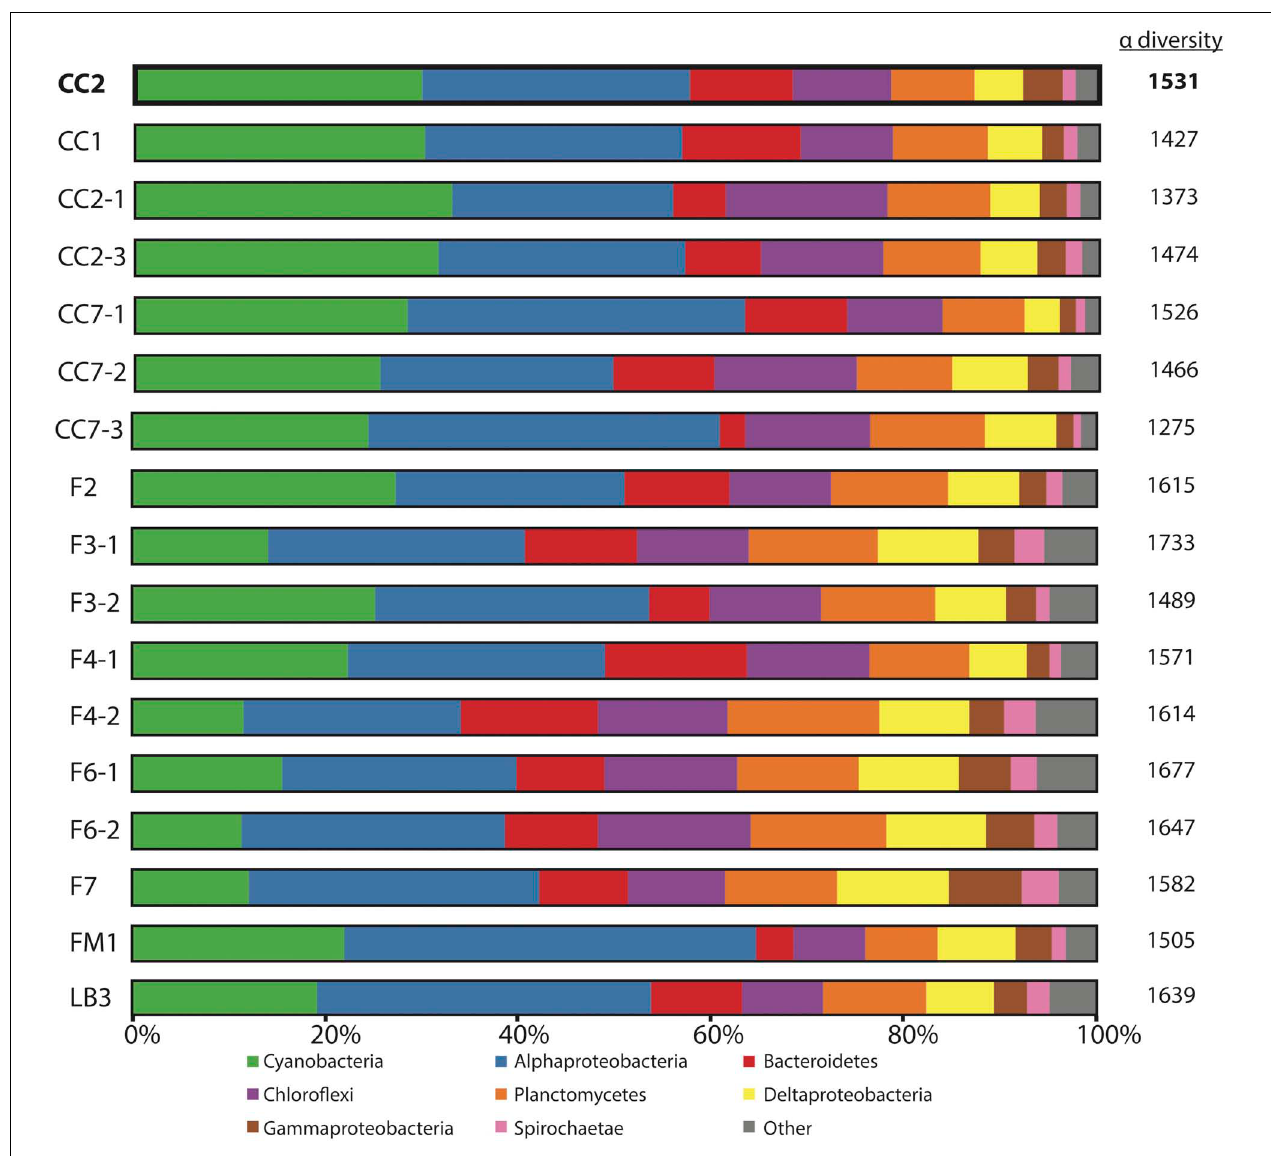
FIGURE 3 | Microbial diversity of polygonal mats recovered using iTag sequencing of the 16S rRNA gene. Relative abundances (%) do not include reads unassigned to any taxon, which comprise ∼ 20% of the total 16S rRNA gene reads. Operational taxonomic units assigned to families constituting a small percentage of total reads are labeled “other.” Alpha diversity is provided to the right of the columns using results rarefied to 3000 reads/sample using the single_rarefaction.py script in QIIME, in order to minimize artifacts imposed by differences in number of reads between samples. Replicate number is given after the